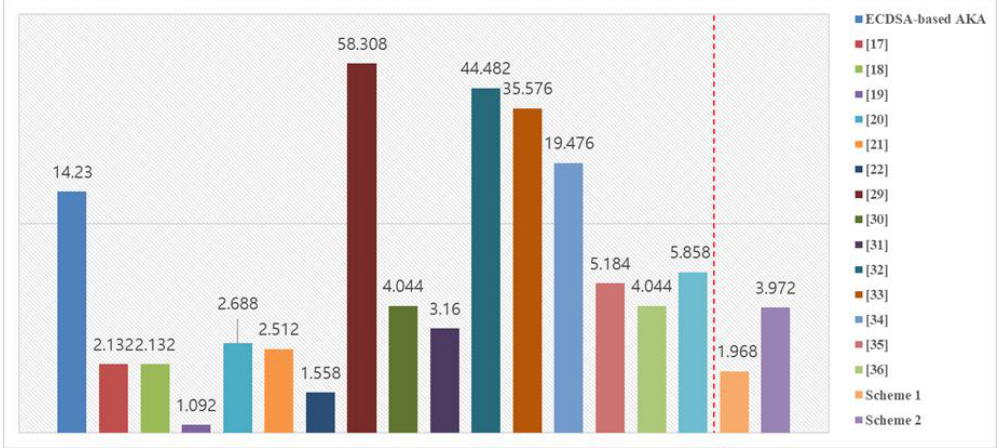
Figure 7. Comparison of key agreement time with existing schemes.